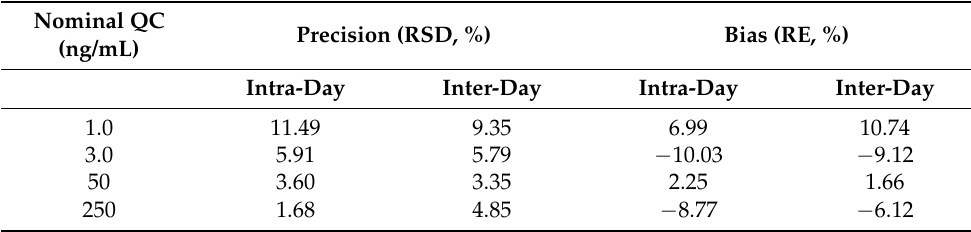
Table 3. Intra- and inter-day precision and bias data of LEM in human plasma samples.